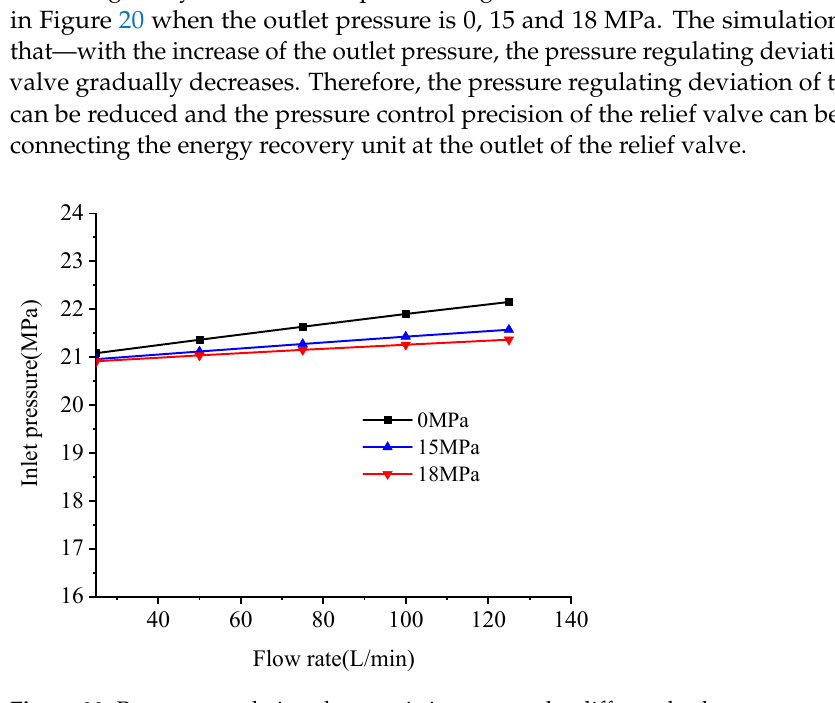
Figure 20. Pressure regulation characteristic curve under different back pressures.